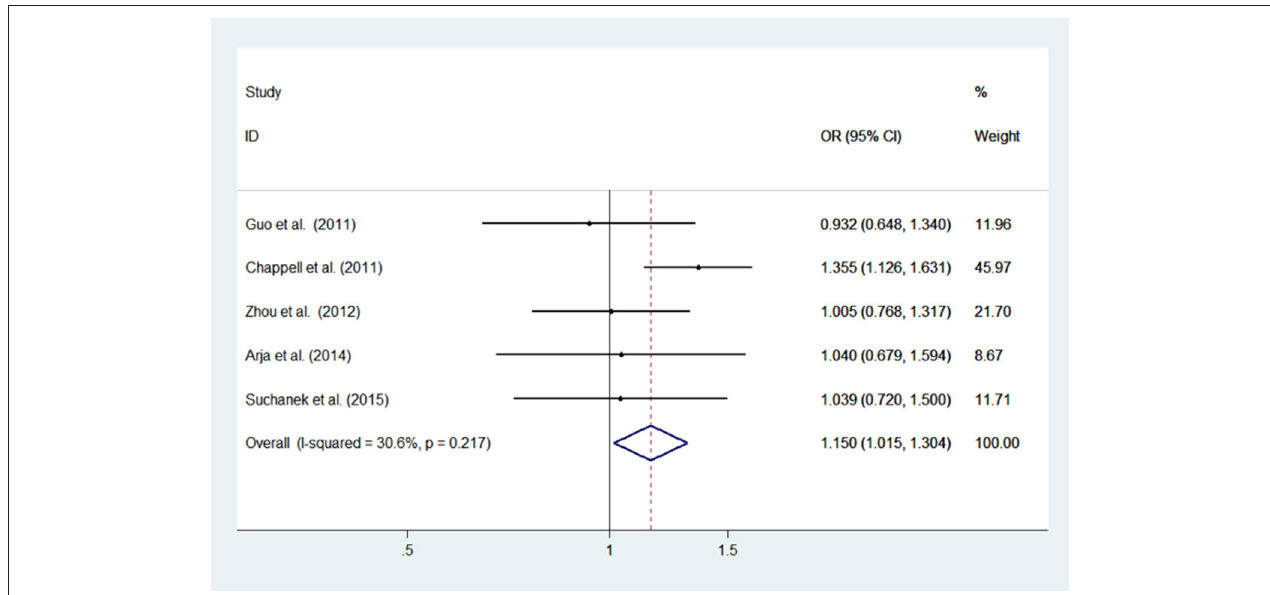
FIGURE 2 | Meta-analysis with a fixed effects model for the association between the IREB2 rs2568494 polymorphism and COPD susceptibility (dominant model, AA + GA vs. GG). OR, odds ratio; CI, confidence interval; I-squared, measure to quantify the degree of heterogeneity in meta-analyses.